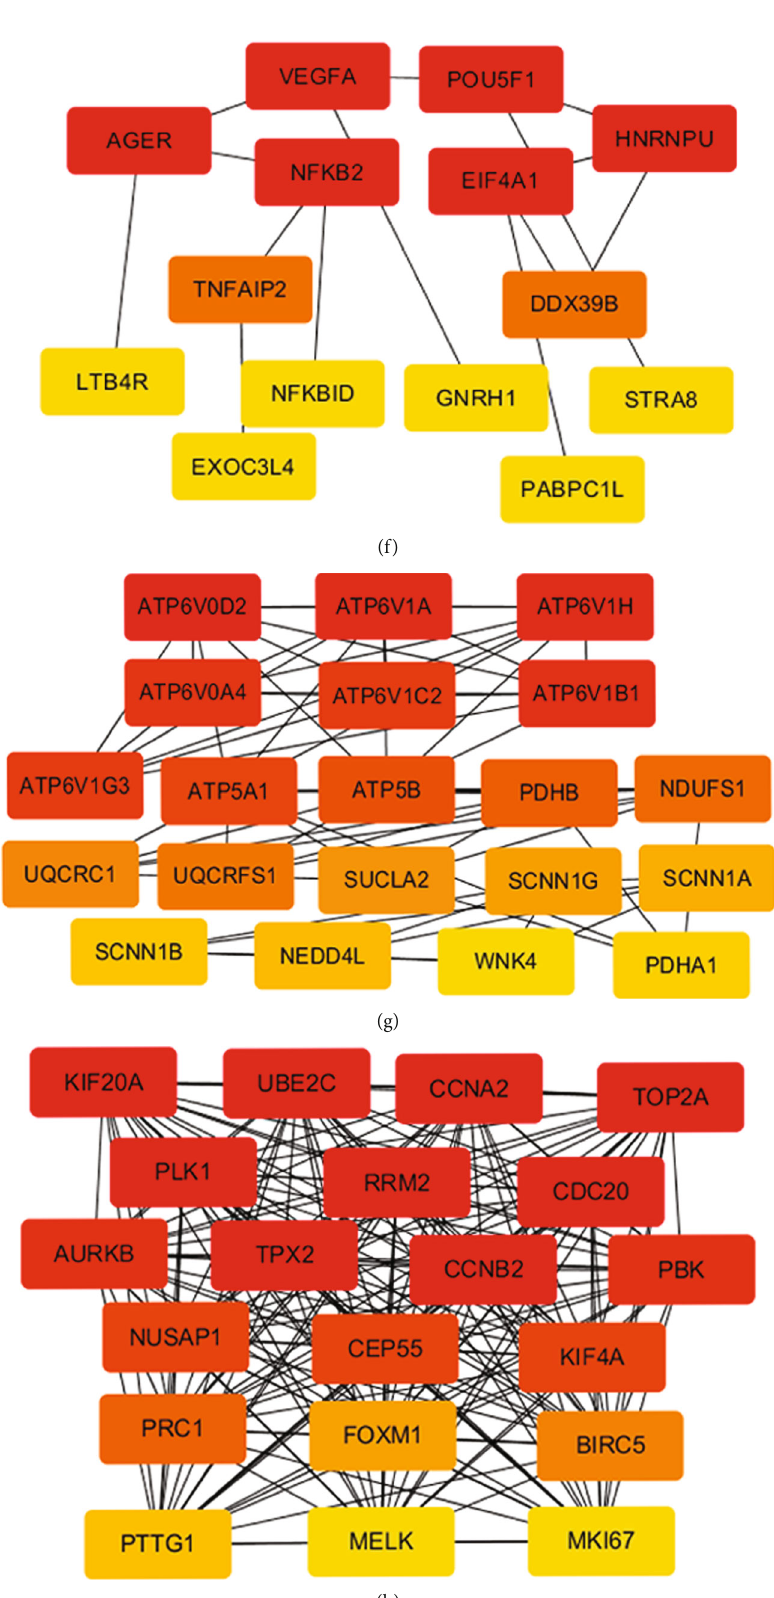
Figure 5: Construction of a PPI network diagram and key gene screening. (a and e) PPI network of DEGs in the MEblack module. (c and f) PPI network of DEGs in the MEyellow module. (b and g) PPI network of DEGs in the MEgreen modules. (d and h) PPI network of DEGs in the MEmagenta